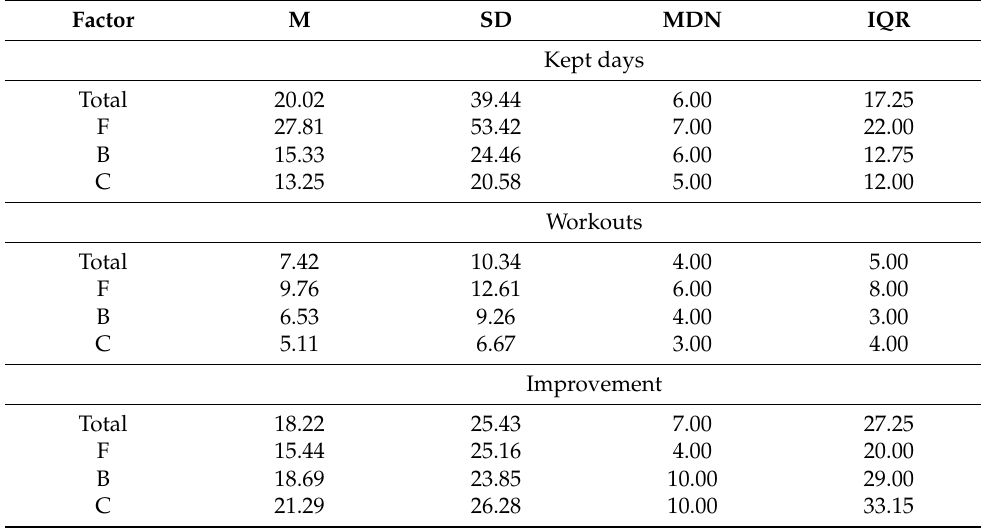
Table 2. Descriptive statistics of the variables (i.e., Kept days, Workouts, Improvement) in the three experimental conditions (F, B, C version).